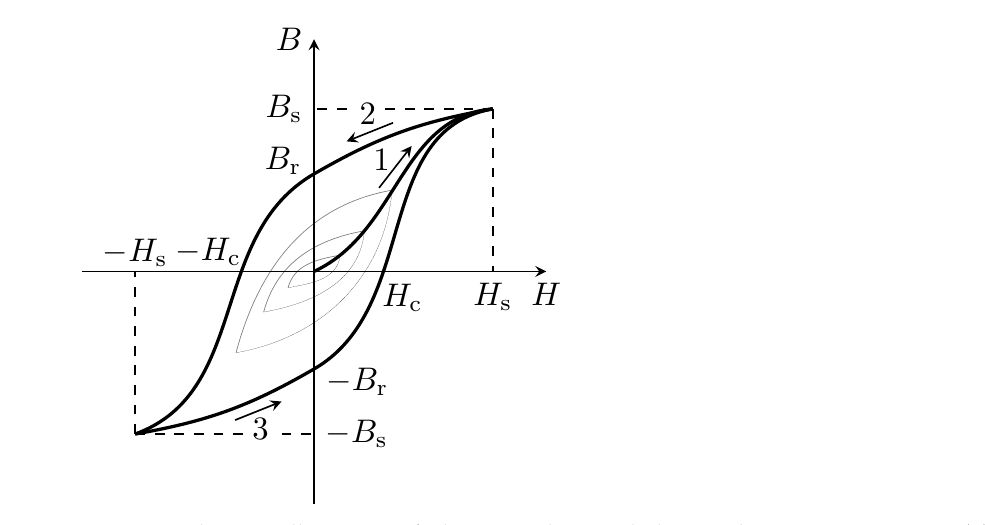
H s , B s and the characteristic ± ±